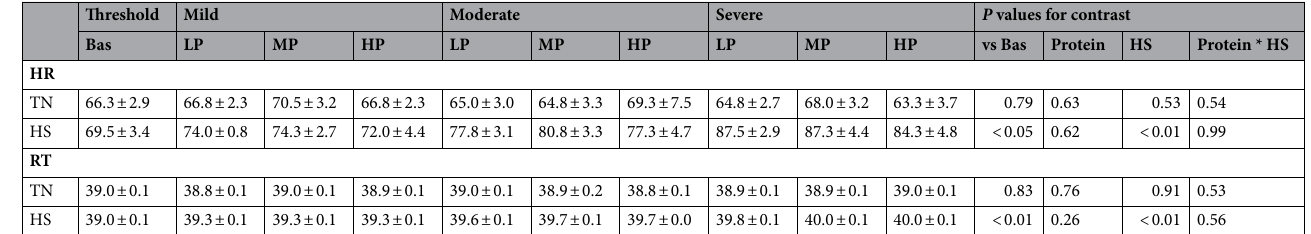
Table 6. Effects of dietary protein levels on heart rate and rectal temperature in Korean native beef calves under heat stress. vs Bas = Control (with 12.5% dietary protein levels, THI 68 to 70) vs 9 experimental diets (with 3 dietary protein levels, with 3 THI levels). THI = Temperature humidity index, THI = (1.8 × Tdb + 32) – [(0.55 – 0.0055 × RH) × (1.8 × Tdb − 26.8). Threshold = THI 70 to 73, Mild = THI 74 to 76, Moderate = THI 81 to 83, Severe = THI 89 to 91. LP = Low protein (12.5%), MP = Medium protein (15%), HP = High protein (17.5%). The data are presented as the means ± standards error (n = 4/group).